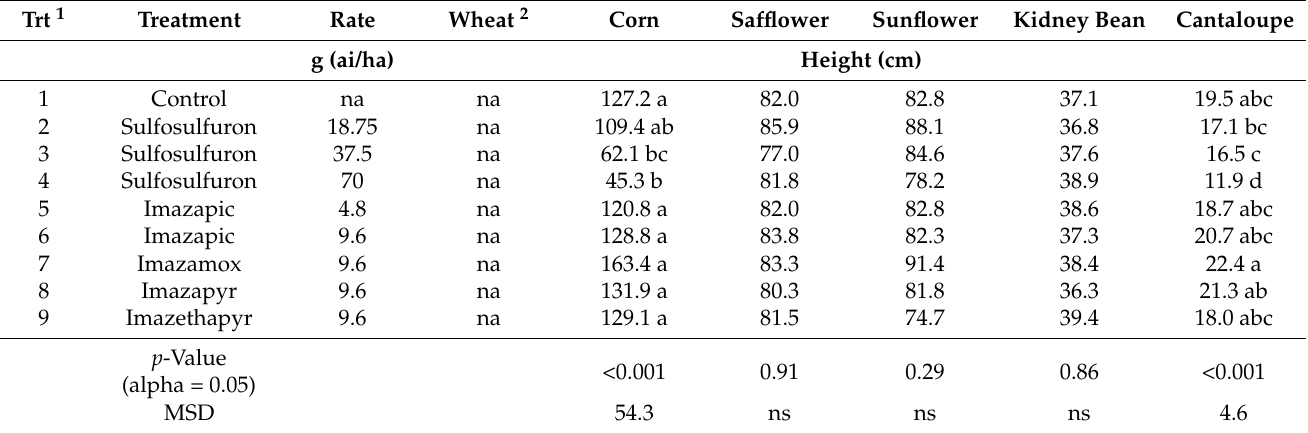
Table 3. Mean 2020 rotational crop heights in the season following 2019 herbicide treatments in tomato for management of branched broomrape in California.